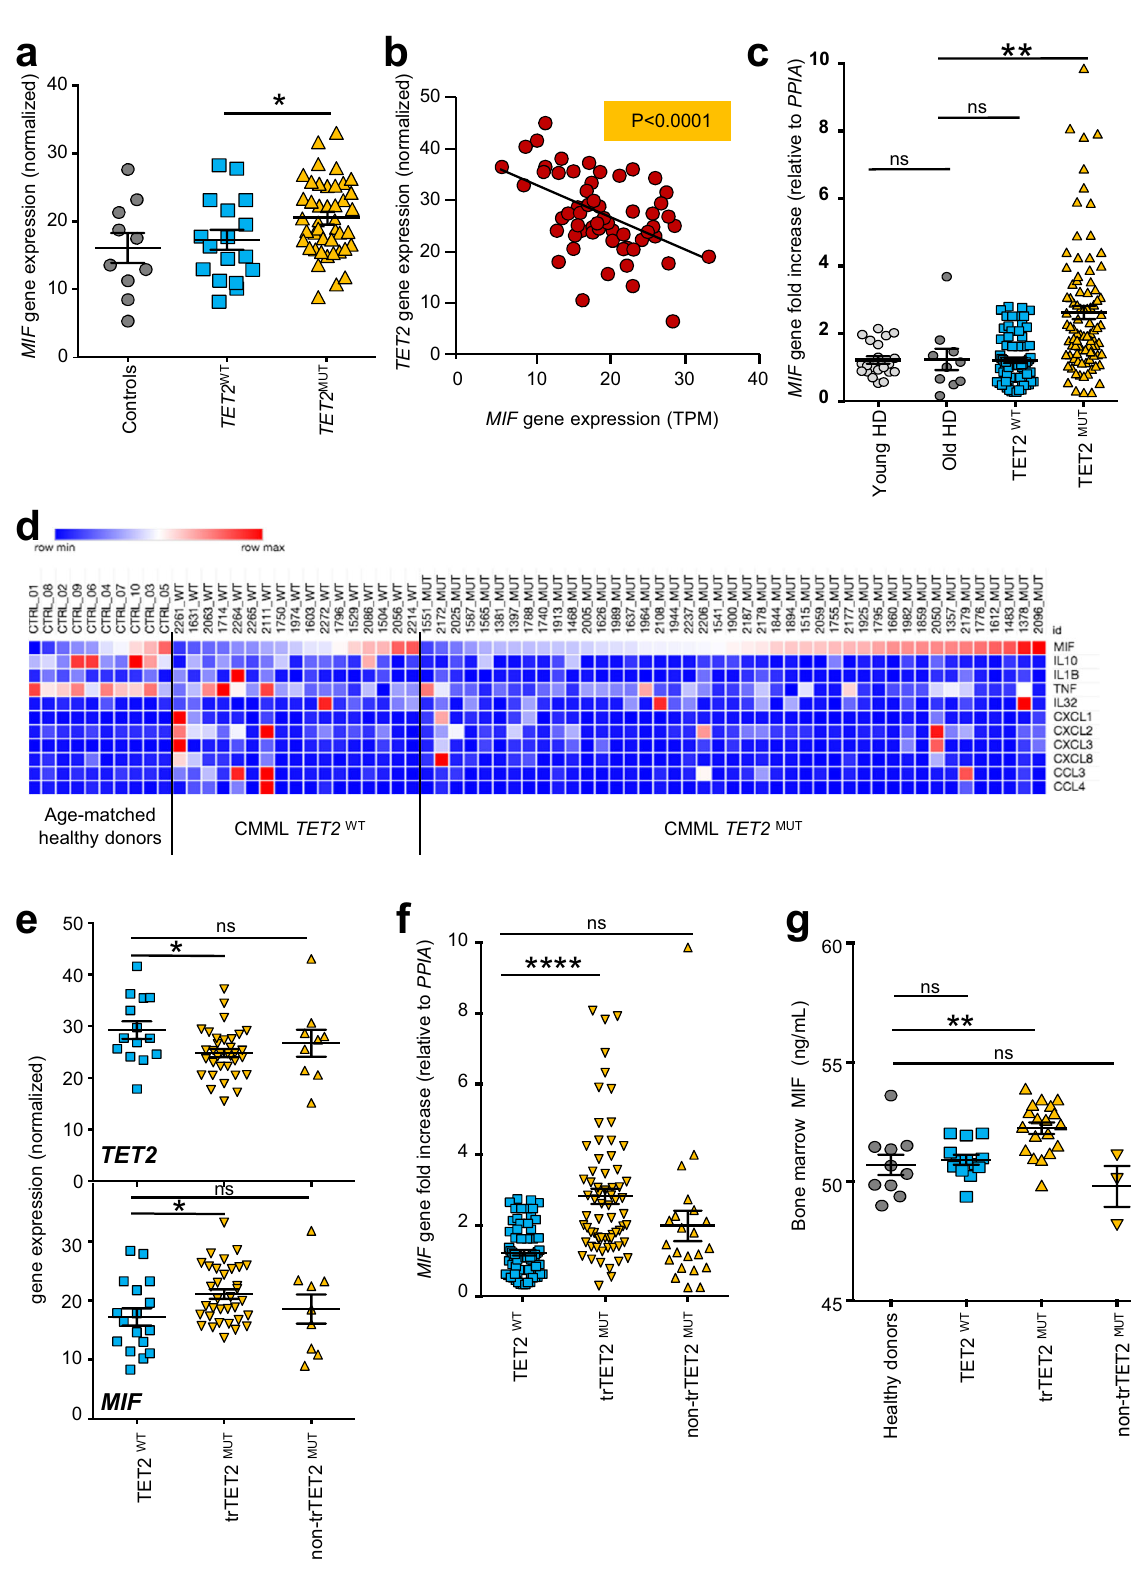
TET2-HA antibody, suggesting a stronger interaction with TET2 in the complex (Fig. 5d). Co-immunoprecipitation experiments in human blood monocytes con fi rmed TET2 inter- action with EGR1 (Supplementary Fig. 6b, c) and validated the ability of TET2 to interact with HDAC1 and HDAC2 (Supple- mentary Fig. 6d).